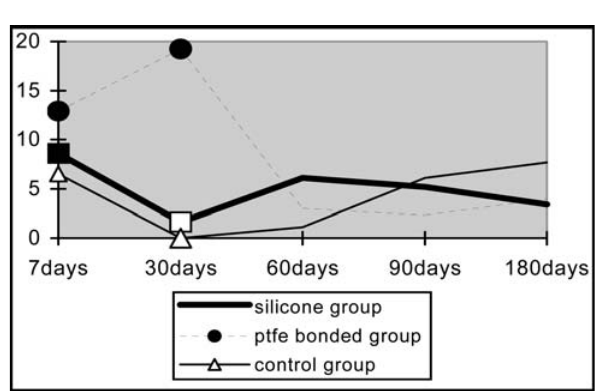
FIGURE 2 - Neutrophils. Comparison among the silicone, bonded e-ptfe and control groups, separately in each subgroup (7, 30, 60, 90 and 180 days). The significant value is indicated with a dark